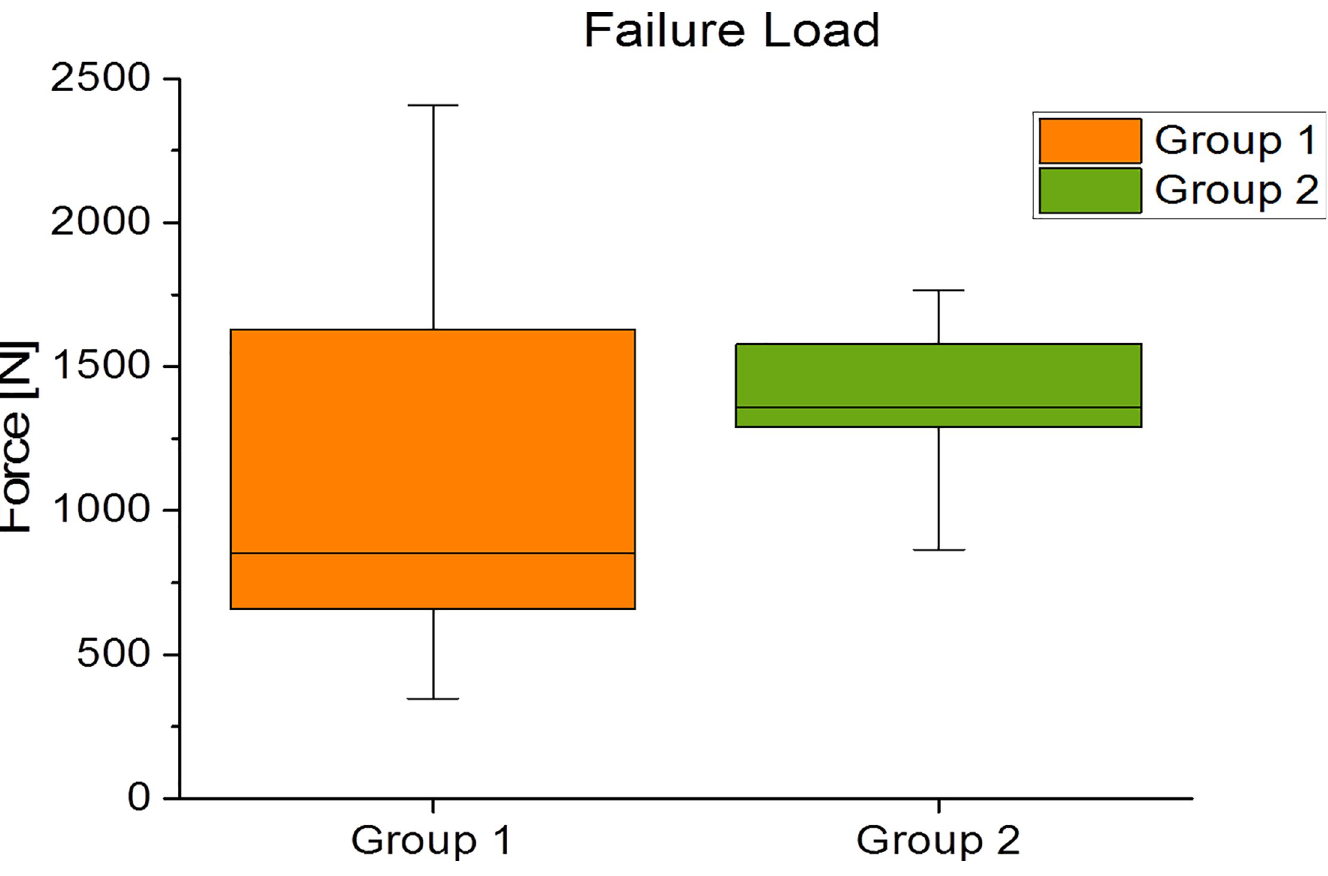
Fig 4. Boxplot of the breaking